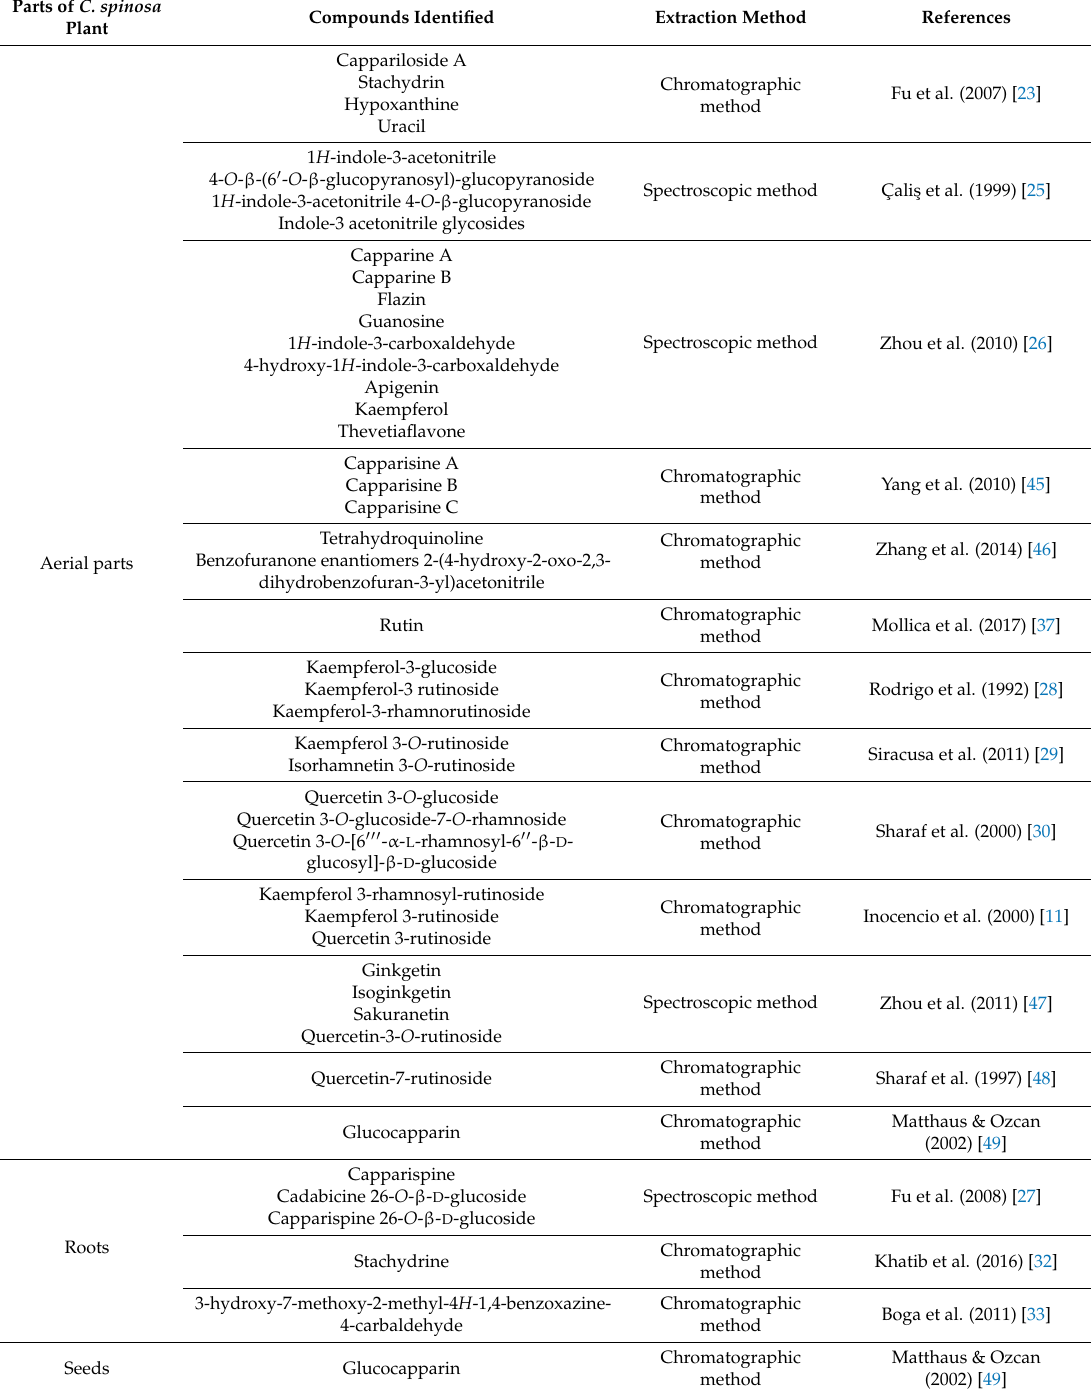
Table 2. Summary of some important constituents isolated from C. spinosa